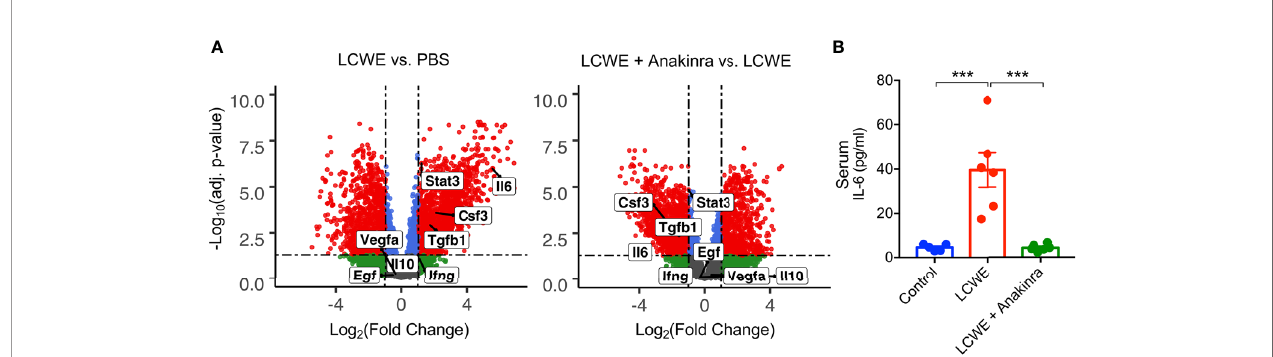
FIGURE 3 | IL-6 expression in the LCWE-induced KD mouse model. (A) Volcano Plots demonstrating differential expression of Stat3 , Il6, Csf3, Tgfb1, Ifng, Il10, Vegfa and Egf in the abdominal aorta of PBS vs. LCWE treated mice and LCWE vs. LCWE + anakinra treated mice. Csf2 was not detected. Red represents FDR < 0.05 and FC > 2, blue represents FDR < 0.05 and FC < 2, green represents FDR > 0.05 and FC < 2. (B) Serum levels of IL-6 in PBS, LCWE and LCWE + anakinra treated mice. Data was analyzed by one-way ANOVA with Tukey ’ s multiple testing comparison (B) . ***p